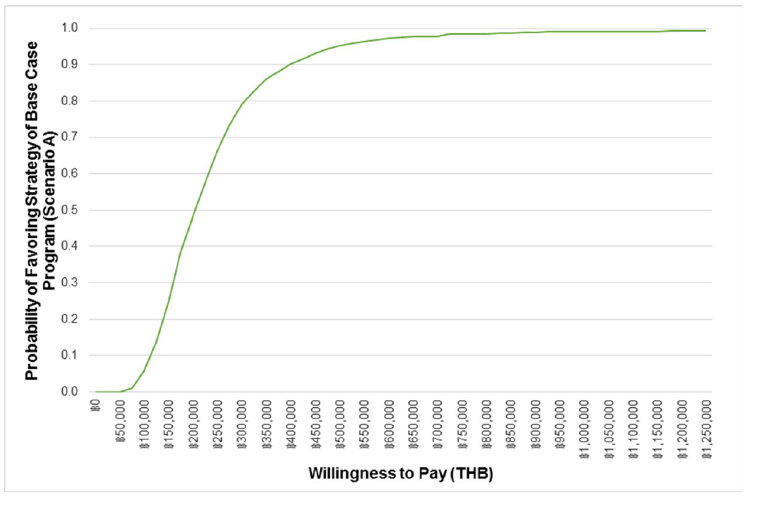
Fig 3. Cost-effectiveness acceptability curve.